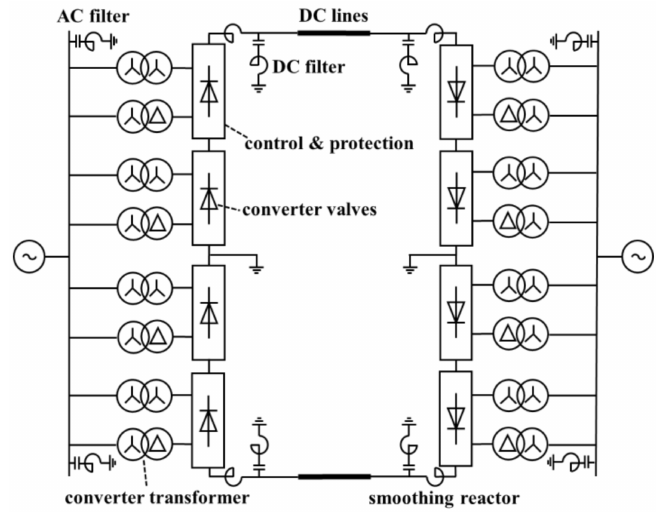
Figure 2. Main devices and topological structure of UHVDC